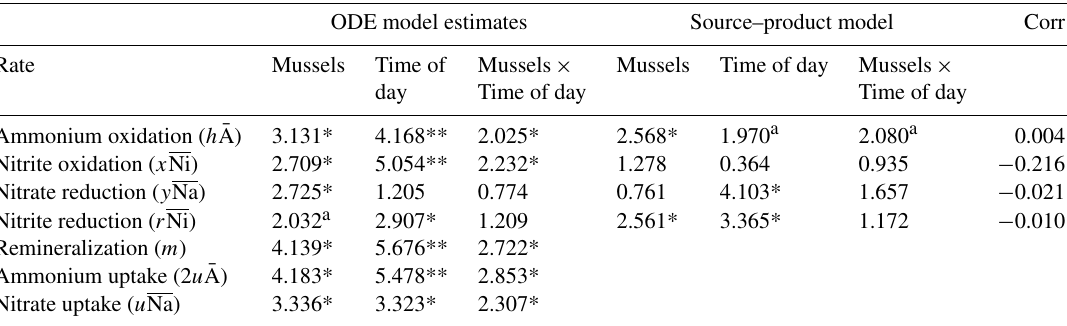
Figure 5. The estimated rates (nmolL − 1 h − 1 ) of microbial nitrogen transformations based on the ODE model in the left panel (Eqs. 2–7) and the source–product model (Eq. (1); e.g., Lipschultz, 2008) with blue shading on the right. (a) Ammonium oxidation ( h ¯ A), (b) nitrite oxidation ( x Ni), (c) nitrate reduction ( y Na), (d) nitrite reduction ( r Ni). Note differences in axes; the differential equation model rates are shown at 4 times the scale of the source–sink model. All other legend elements are as in Fig. 2. Table 4. A statistical summary of the role of mussels, day vs. night and their interaction on the rates of nitrogen transformations (in nmolL − 1 h − 1 ) estimated in both our ODE models and the traditional source–product models. Linear mixed effects models using tidepool as a random effect were used on log-transformed or square-root-transformed estimates from Eq. (2–7); t values are given; a = 0.10> p >0.05, * p <0.05, ** p <0.001. The correlation between coefficients estimated from each method is shown in the last column; no coefficients were significant. There were 40 observations for the ODE model and 20 for the source–sink